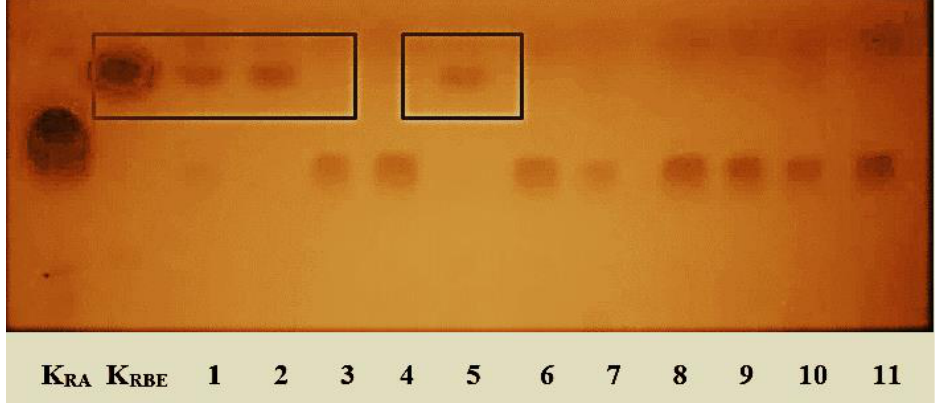
Figure 1. Efficacy of lipases in the in situ process catalyzed by rapeseed oil lipase using butanol: